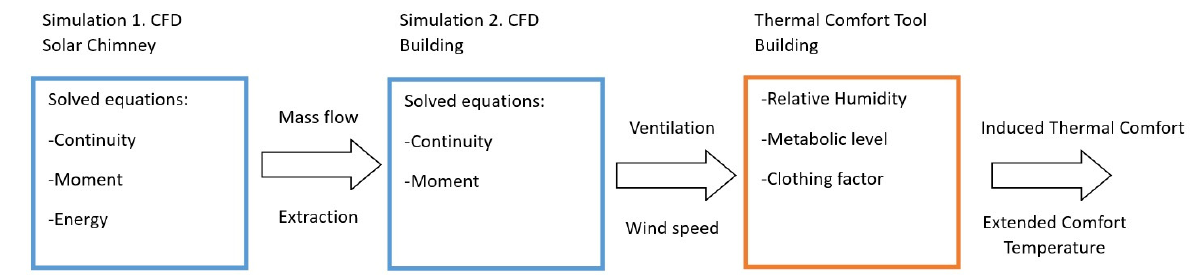
Figure 4. Overall simulation strategy.